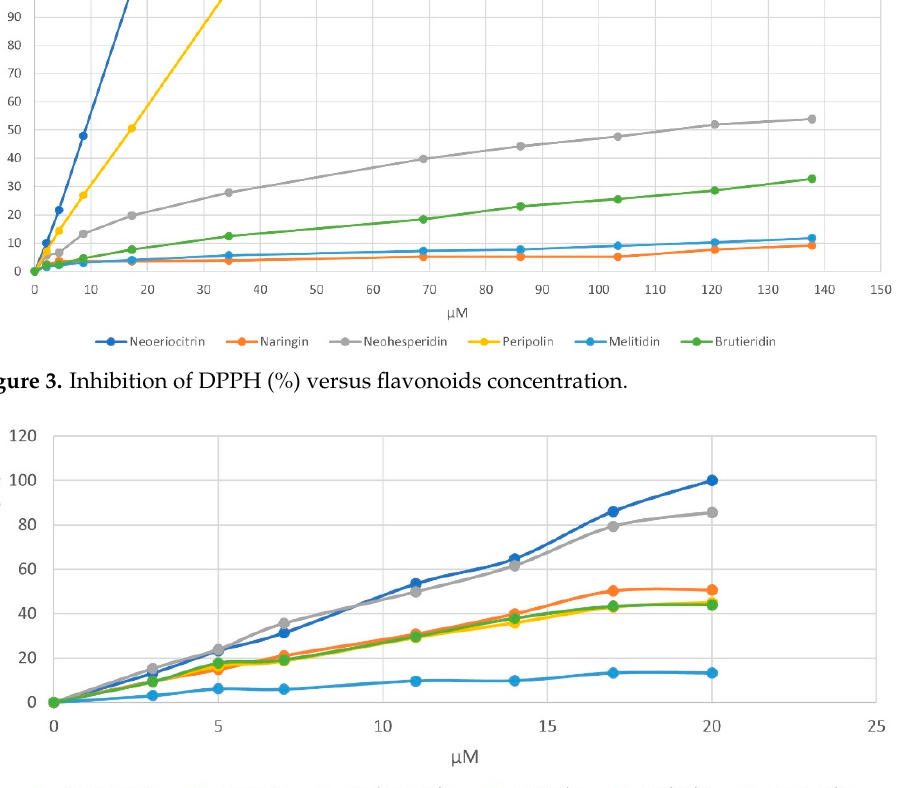
Figure 5. Ferric-reducing ability of pure flavonoids. 3.3. Computational Studies of the Antioxidant Capacity of HMG Flavonoids To further support the experimental results, a set of computational studies focused on compounds 1 , 3 , 4 and 6 . Such species were selected based on the measured radical